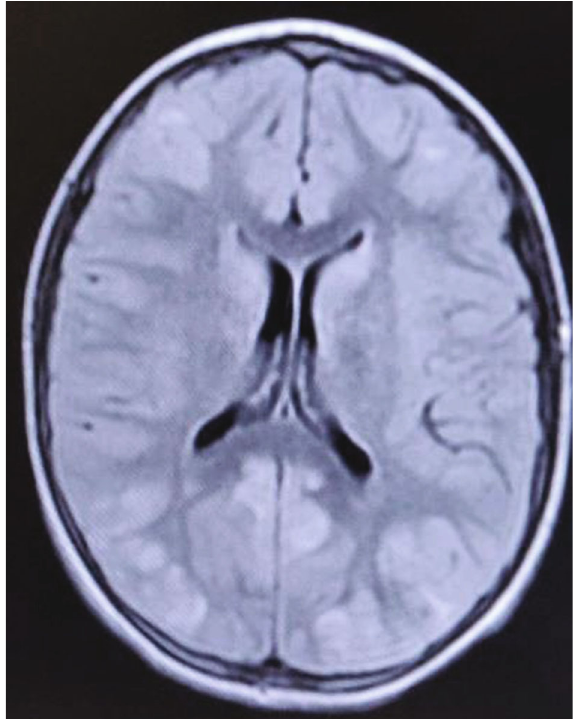
Figure 1: A cerebral magnetic resonance imaging: the main section shows cortical and posterior cortical lesions in hyper signal in